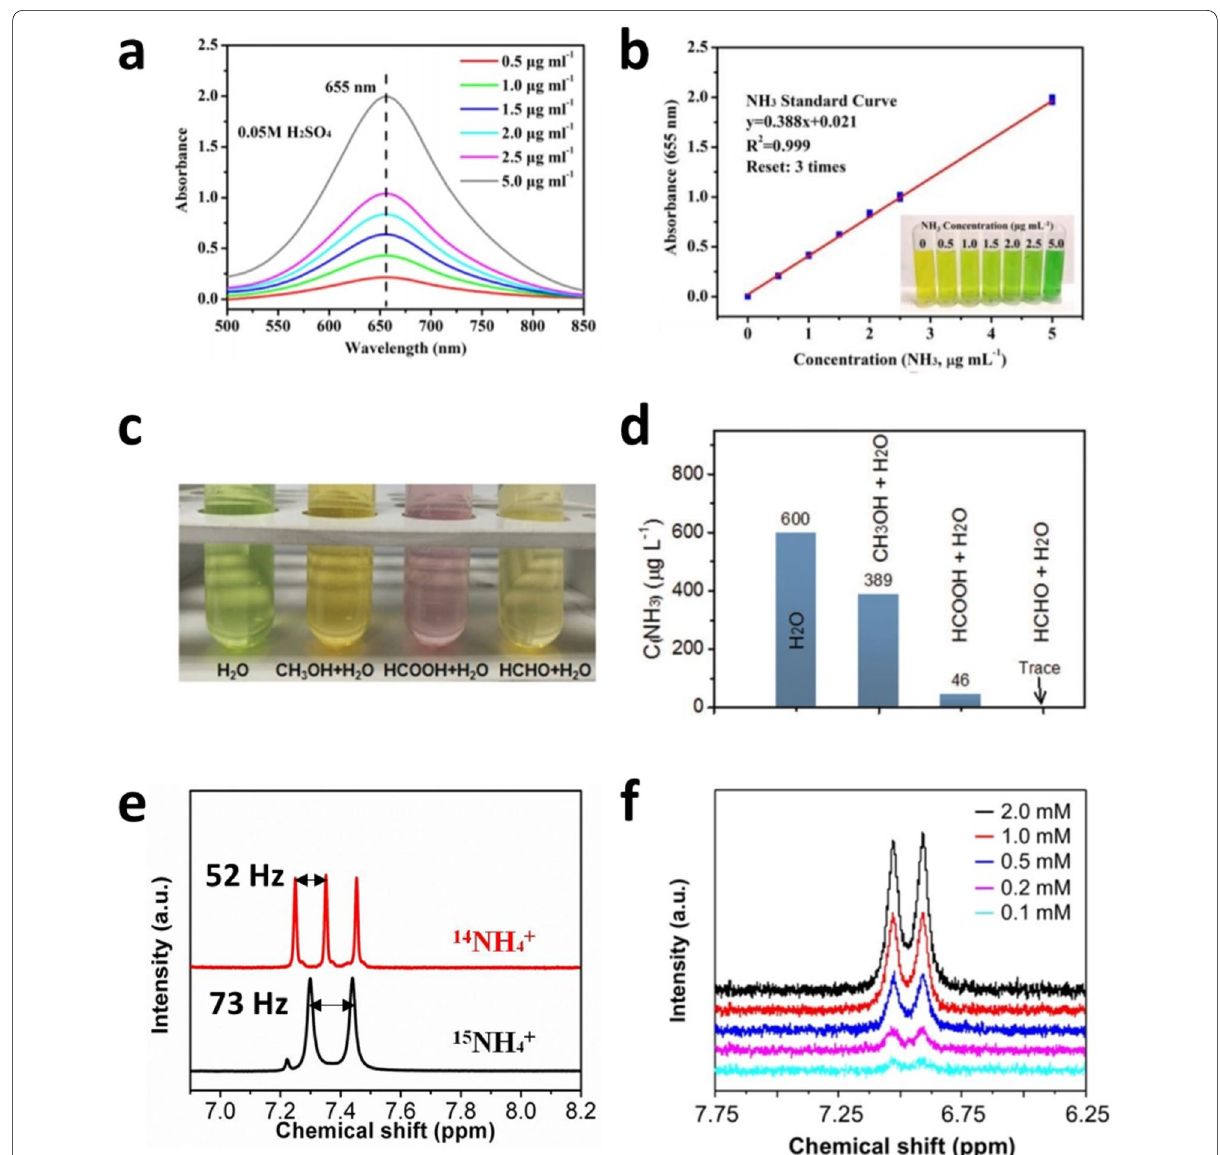
Fig. 2 a Spectrum and b standard curve of UV–Vis spectrophotometer with standard solutions from 0.5 to 5.0 µg Reproduced with permission [25]. Copyright 2019, PNAS. c , d Interference impact on measurements of produced NH 3 in solution with CH 3